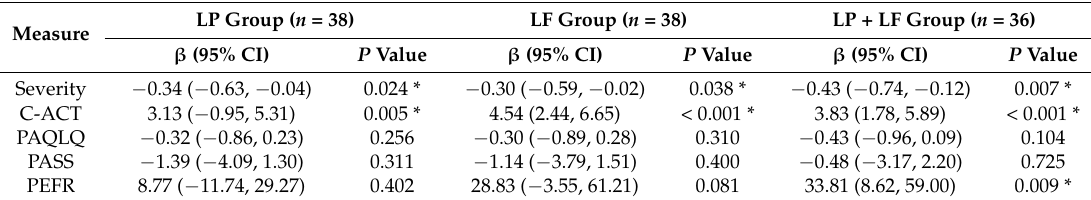
Table 3. The p values and effect sizes ( β ) compared with the placebo group ( n = 35) using a generalized estimating equation